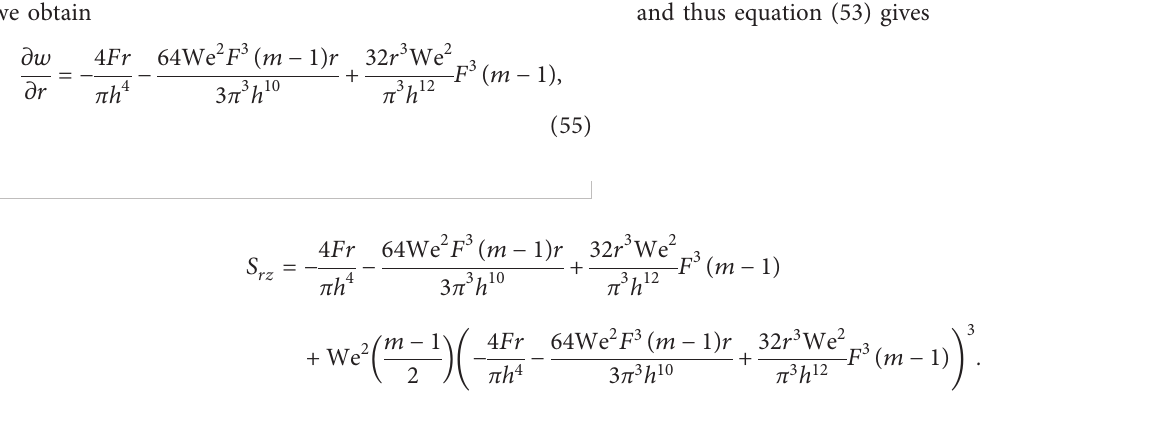
We = 0.0 We = 0.2 Figure 4: Wall shear stress variation for the Carreau model for n � 2 , L � 1 , F � 1 , and m � 0 .